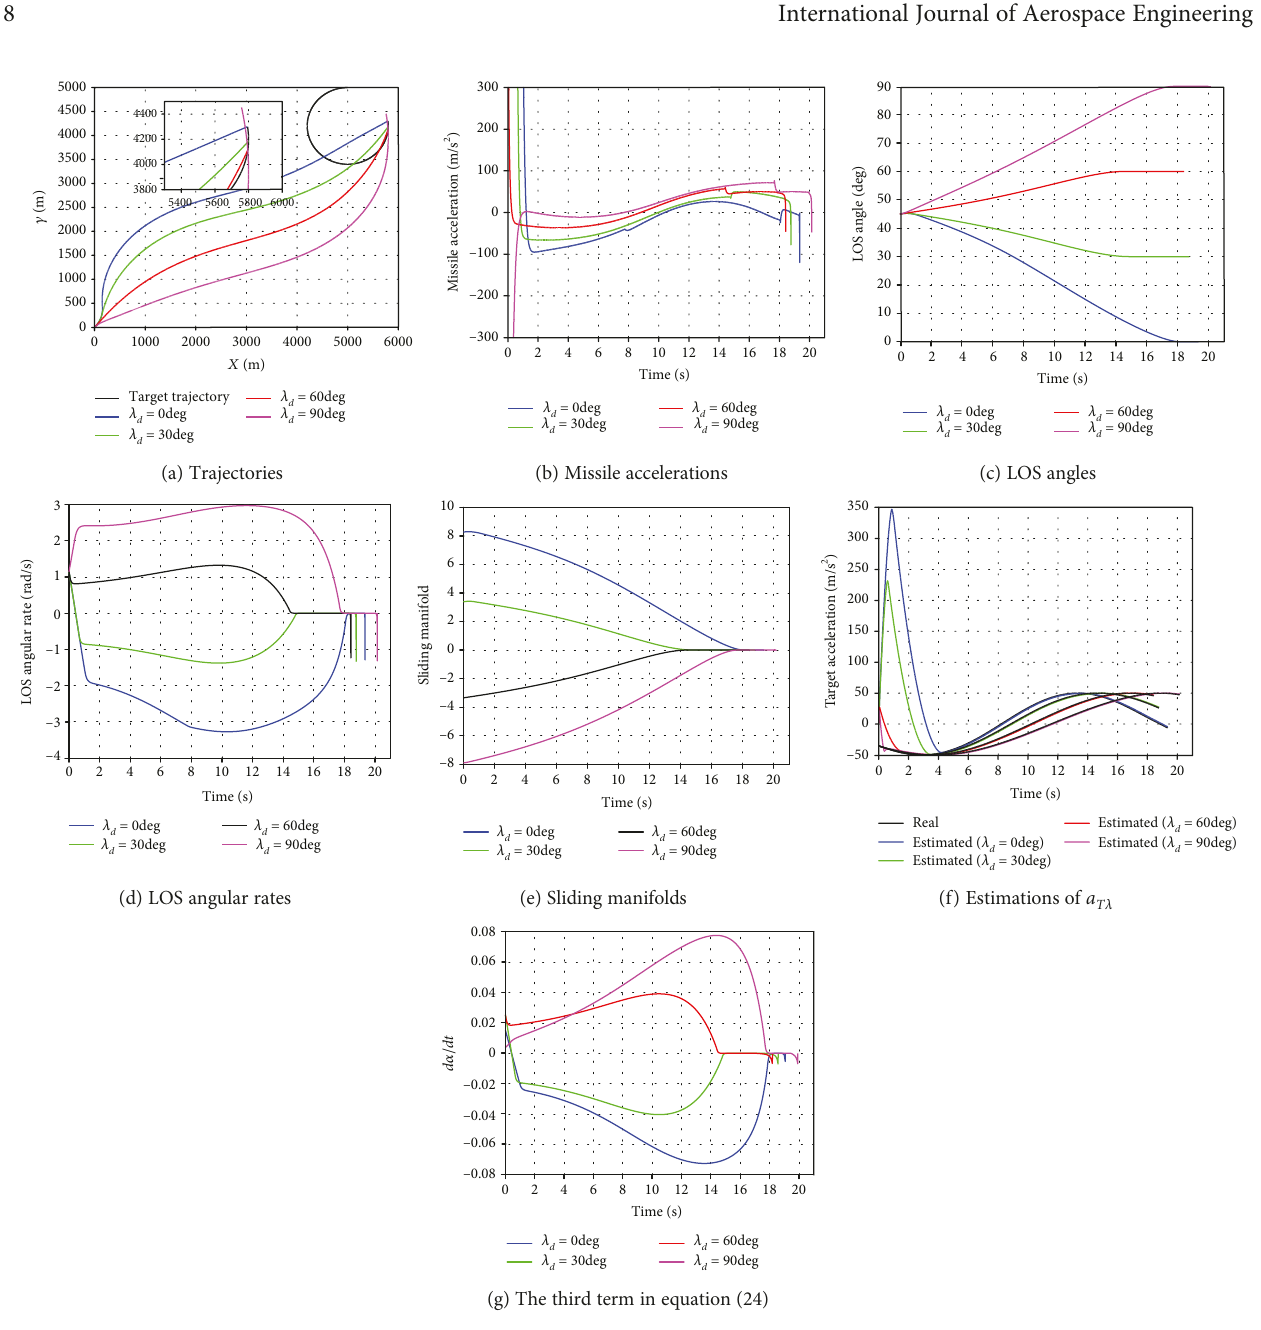
Figure 3: Simulation results of case